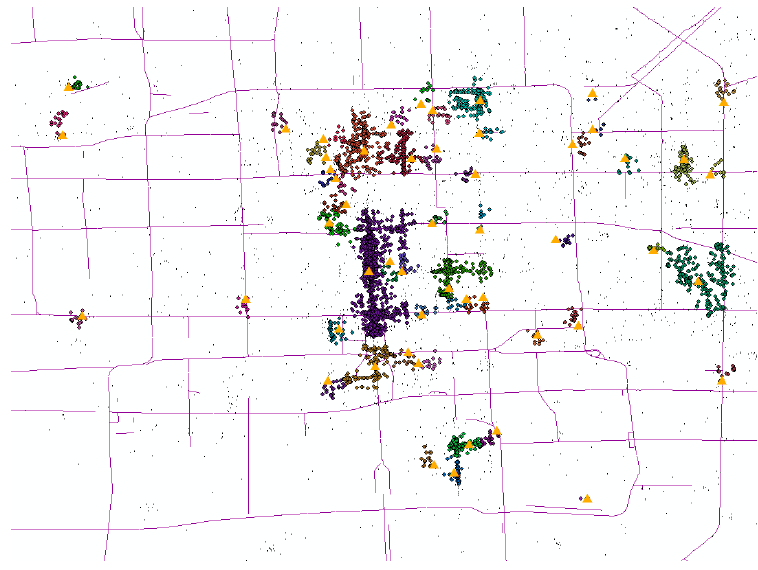
Figure 10. DBSCAN-based cluster center distribution map after tourist attraction discovering.